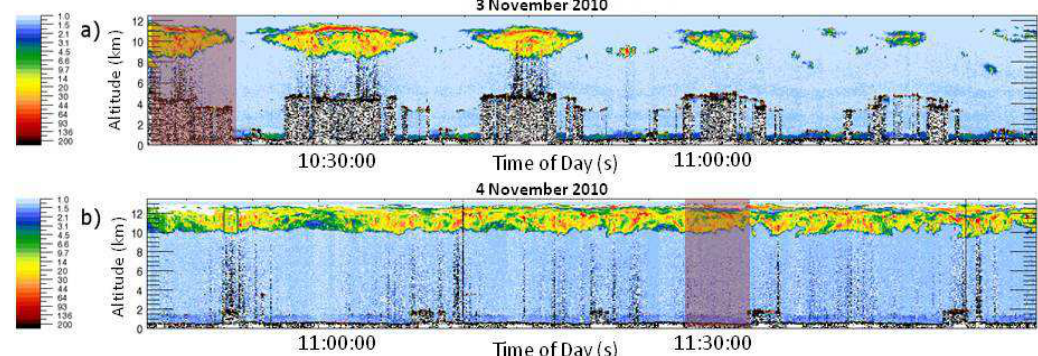
Fig. 2. (a) Backscatter ratio from HSRL for a 75min time frame of the flight of 3 November 2010 showing two descending cloud layers alternating with cloud-free areas. One cloud layer is situated between 9 and 13km altitude, and a second one below 5km altitude. The investigated time series is highlighted in red. (b) Backscatter ratio from HSRL for a 75min time frame of the flight of 4 November 2010 showing cirrus layer between 9 and 13km altitude. The investigated time series is highlighted in red. Time is given in UTC.